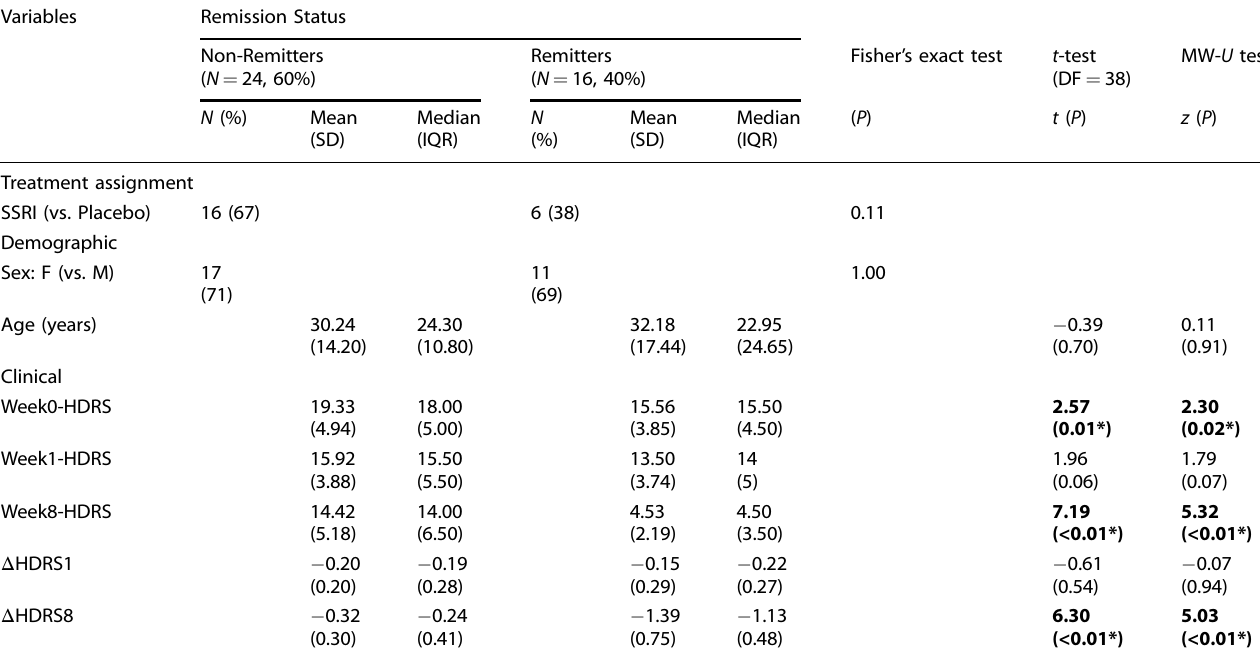
Table 1. Participants ’ demographics and clinical characteristics, strati fi ed by remission status.